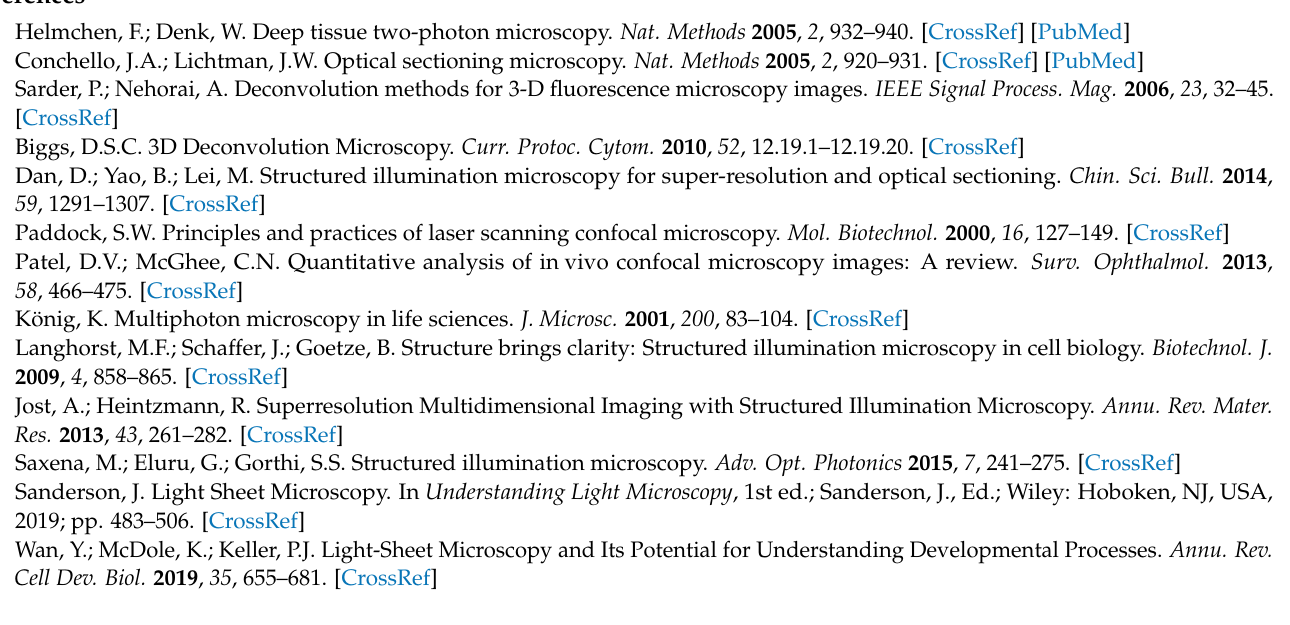
Figure S4: NR-IQMs values of planes recovered for the RBC with suspected infection; Figure S5: NR-IQMs values of single microbead and RBC with suspected infection for the 1 µ m z-step and 0.5 µ m z-step images; Figure S6: MCR images of single microbead for left samples (a), middle samples (b), right sample (c), and 0.5 µ m z-step (d); Figure S7: MCR images of RBC with inner earphone-shape for left samples (a), middle samples (b), right sample (c), and 0.5 µ m z-step